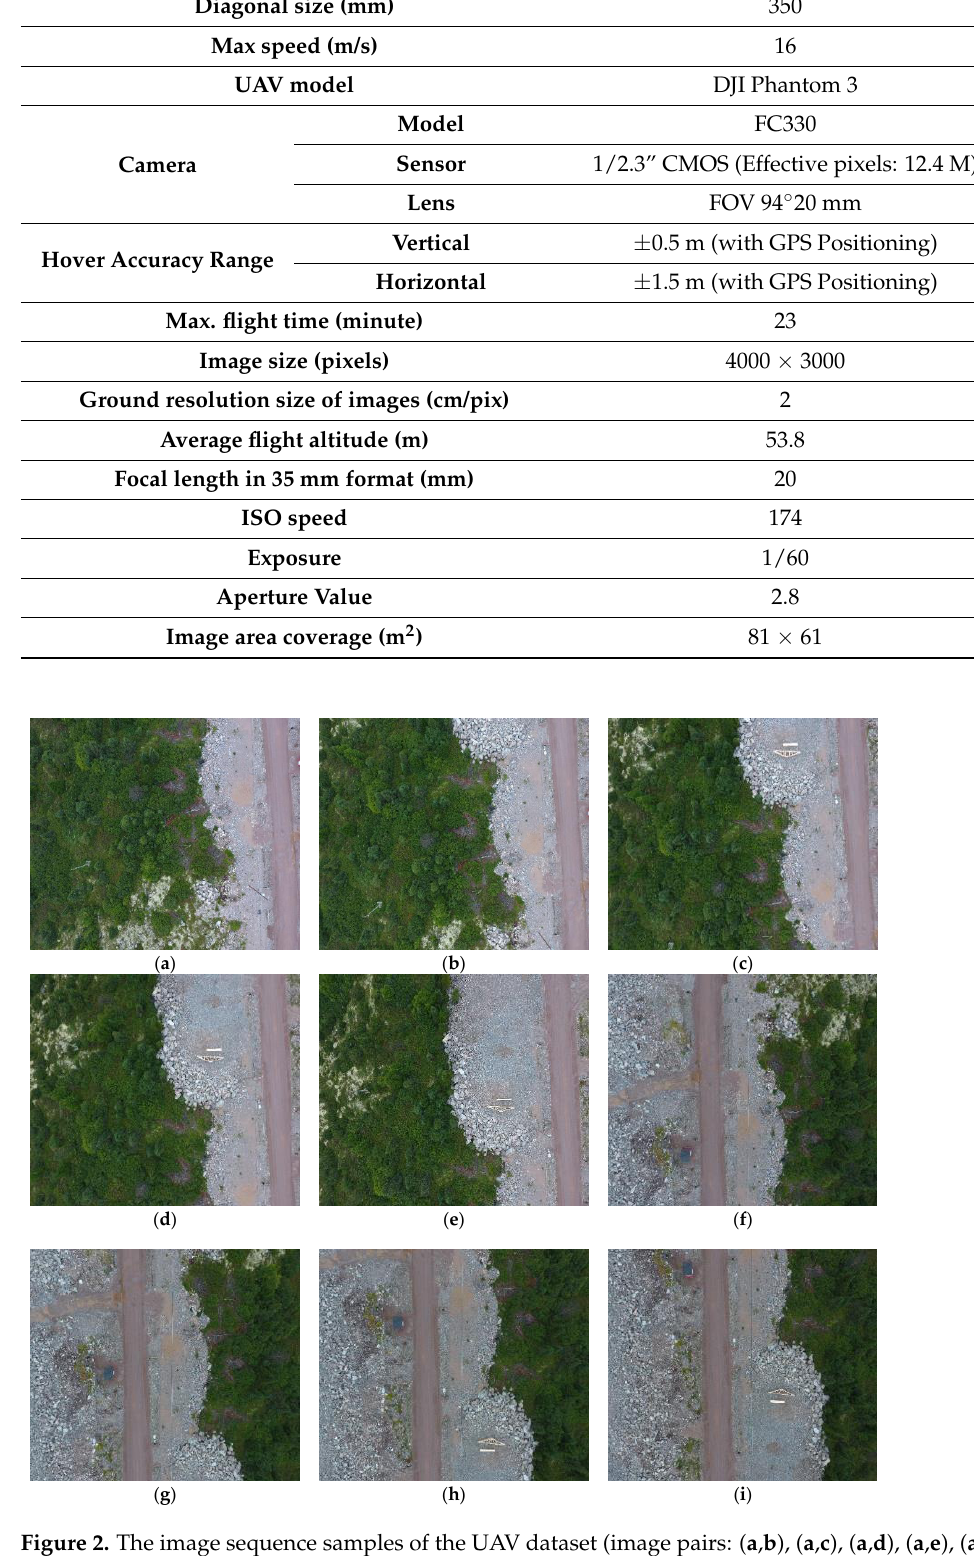
Figure 2. The image sequence samples of the UAV dataset (image pairs: ( a , b ), ( a , c ), ( a , d ), ( a , e ), ( a , f ), ( a , g ), ( a , h ), and ( a , i )).